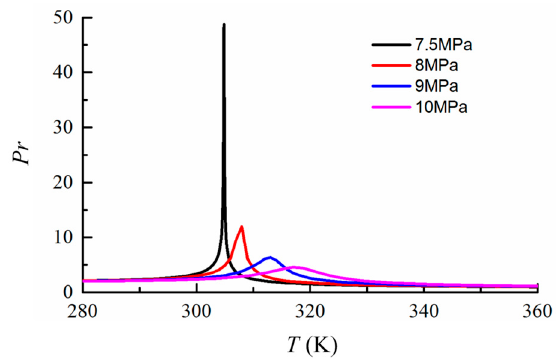
Figure 3. Variations of the Pr with pressure and temperature.